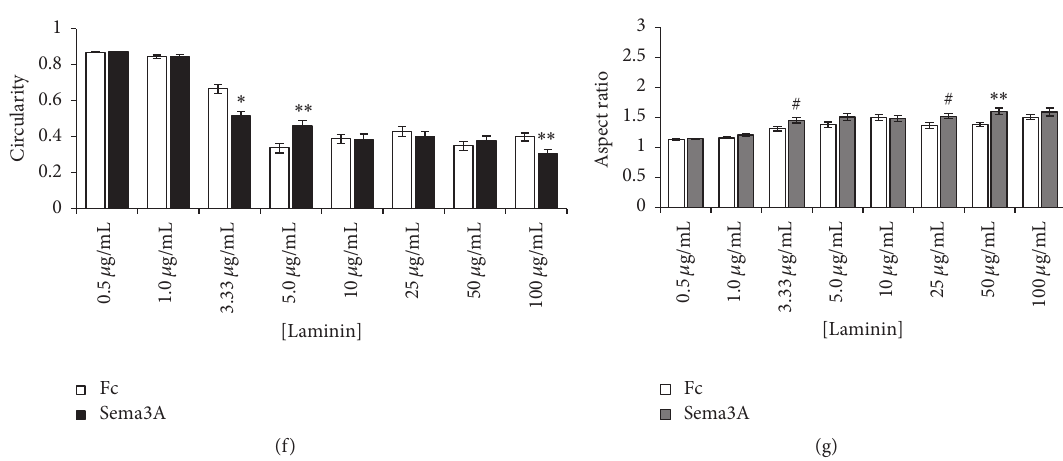
Figure 4: Sema3A alters cell morphology on collagen and fibronectin but has minimal effects on laminin. (a) Example images of cells stained with TRITC-phalloidin. Rounded cells display circularity close to 1 and a low aspect ratio (close to 1), while more elongated cells have circularity close to 0 and a high aspect ratio (greater than 1). Scale bar = 20 𝜇 m. Cell circularity and aspect ratio were measured from cells exposed to substrata coated with increasing concentrations of collagen ((b) and (c)), fibronectin ((d) and (e)), and laminin ((f) and (g)). Sema3A consistently reduced circularity and increased aspect ratio on substrata coated with increasing concentrations of collagen, while the effects of Sema3A on fibronectin and laminin were less consistent. Graphed data represent the mean ± SEM from at least 80 cells for each condition. ∗ 𝑝 < 0.001 , ∗∗ 𝑝 < 0.005 , and # 𝑝 < 0.05 indicate statistical difference relative to IgG1 Fc control; two-sample 𝑡